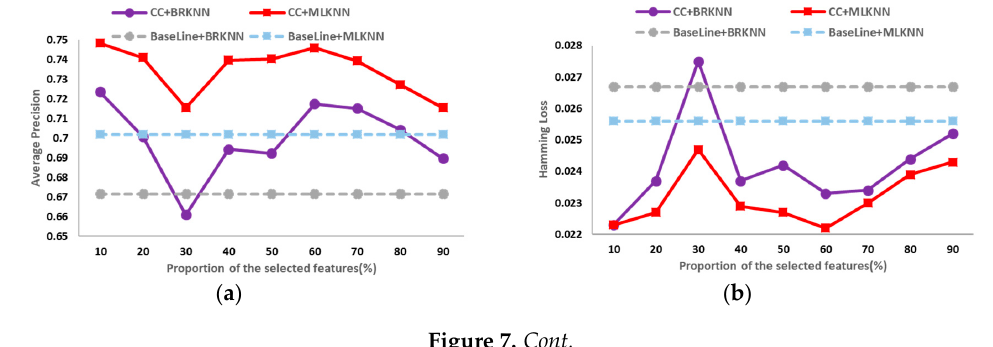
Figure 6. Experimental results on Health data set. ( a ) Average Precision; ( b ) Hamming Loss; ( c ) One Error; ( d ) Coverage; ( e ) Ranking